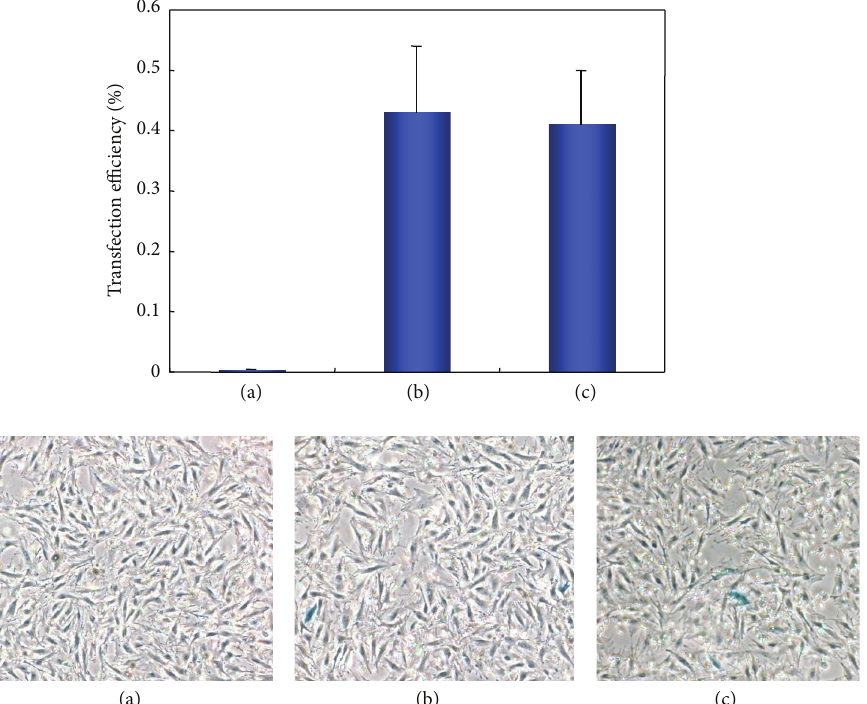
Figure 3: Gene transfection into MSCs. (a) Transfection with ald-dex (1/1 of PLL) and PLL. (b) Transfection with ald-dex (1/4 of PLL) and PLL. (c) Transfection with ald-dex (1/12 of PLL) and PLL.